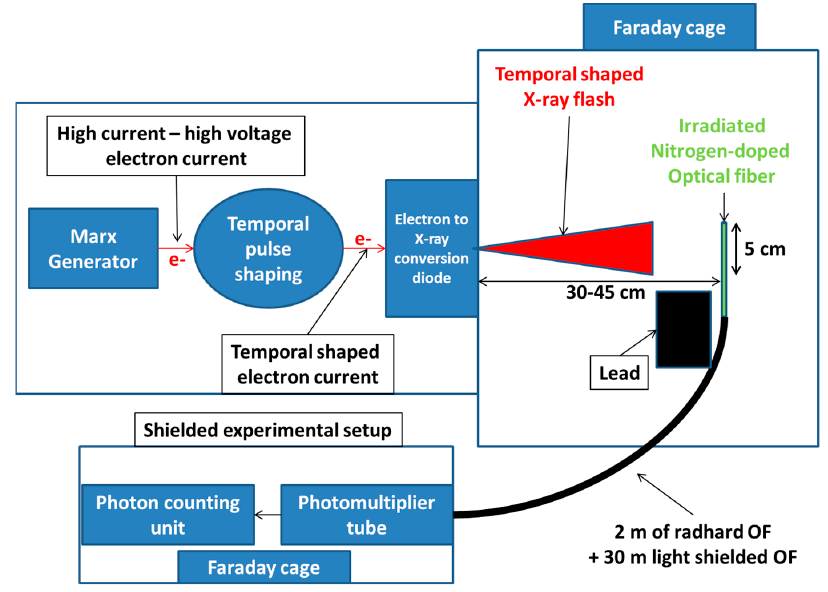
Figure 3. ASTERIX experimental irradiation area and experimental setup developed to measure the RIE induced in the N-doped fiber under